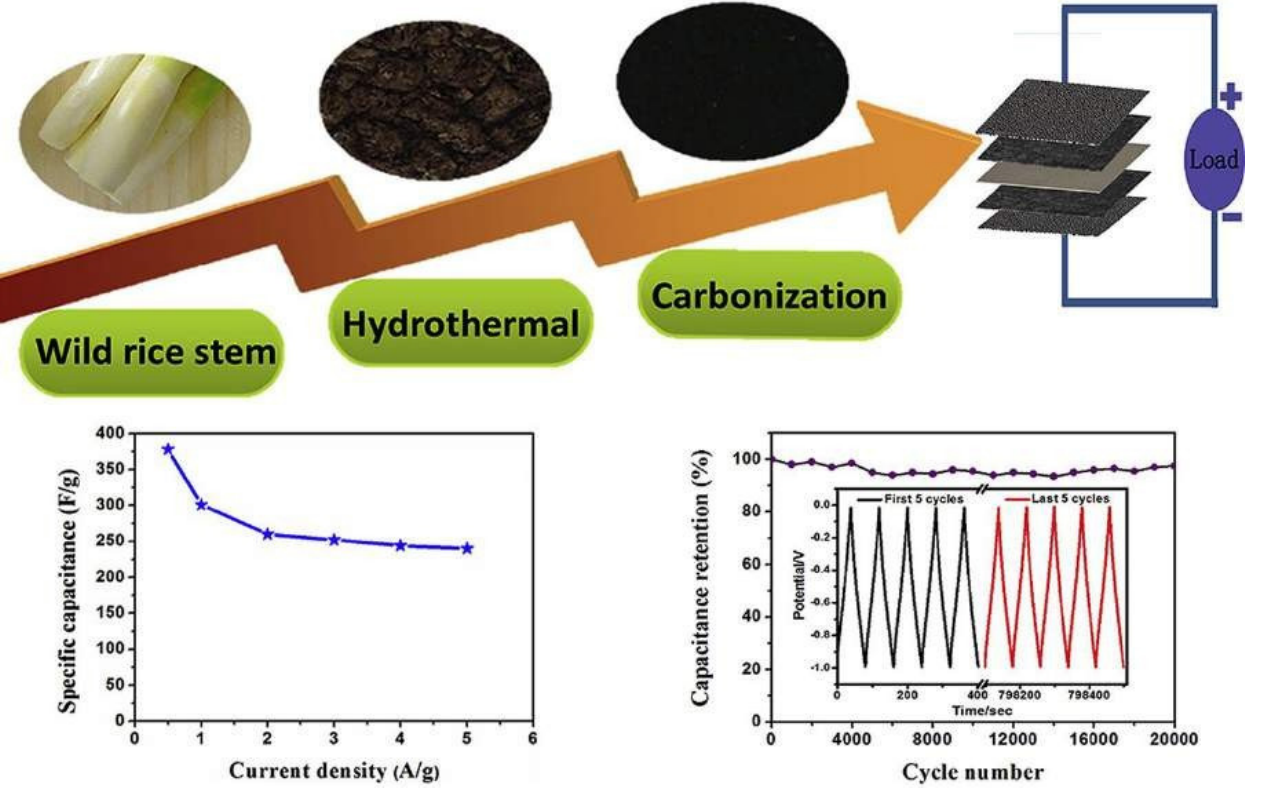
Figure 34. Porous carbon material originated from wild rice stem and used in supercapacitors. Reproduced with permission from [120].